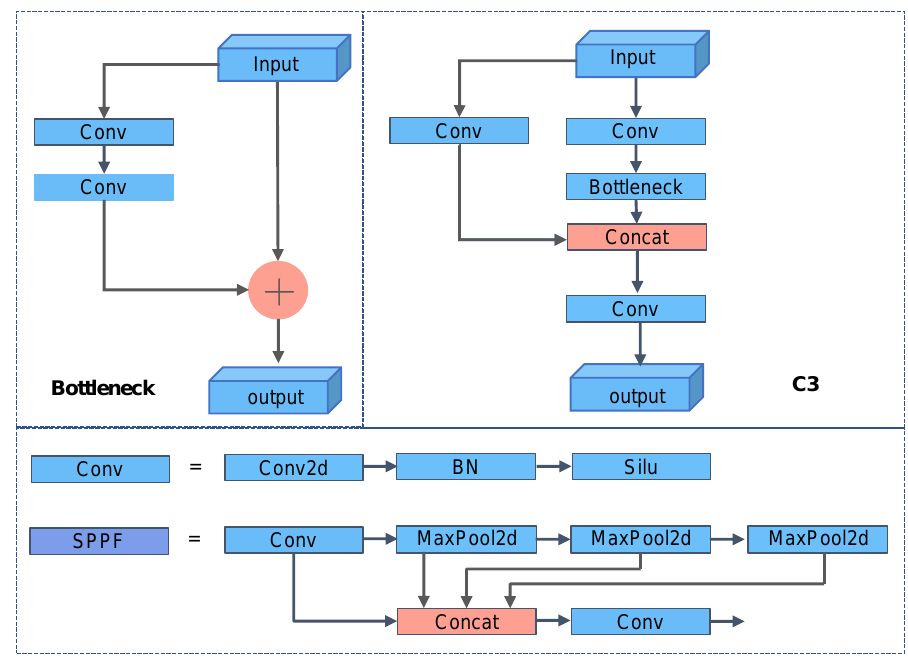
Figure 2. Composition diagram of each module.